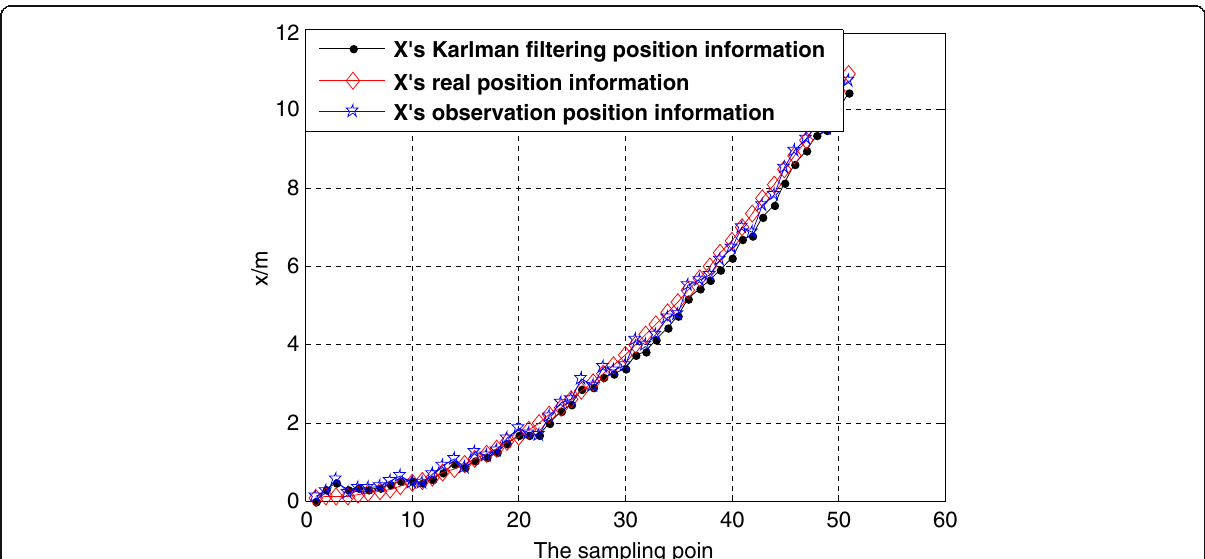
Fig. 10 X orientation effect. It can be found from this figure the orientation effect of X direction. Estimated curve for actual location estimation is more accurate and basically could reflect the actual status of robot at the moment, using Kalman filtering algorithm, and is used for the observation location information filtering